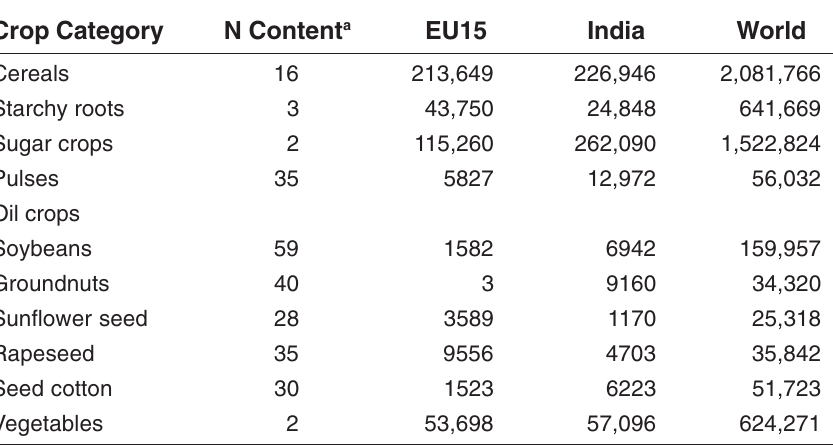
Crop Production in EU15, India, and the World in